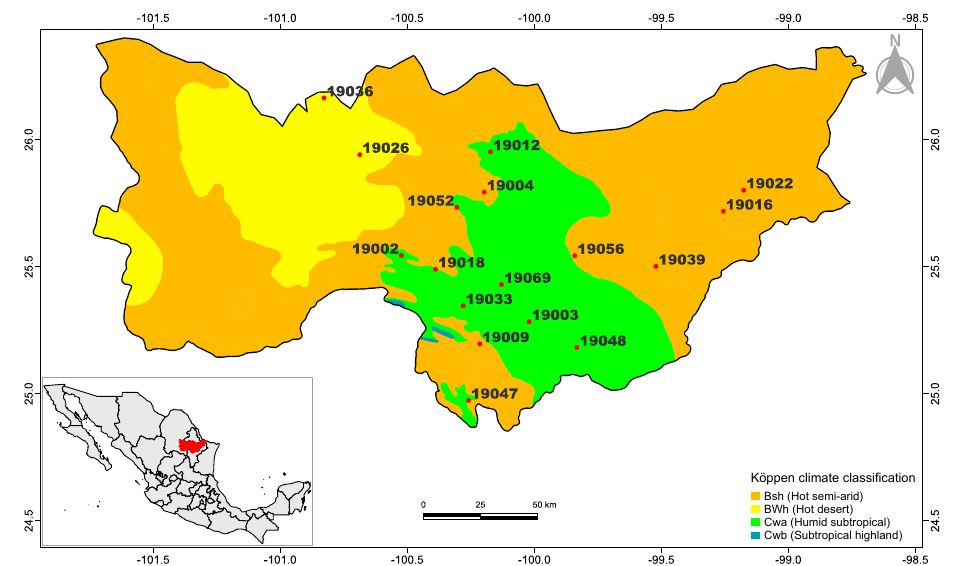
Figure 1. CONABIO’s clustering of Río Bravo-San Juan Basin, Mexico, by using the Köppen climate classification